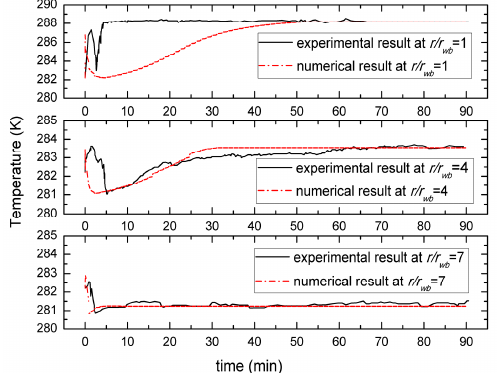
Figure 3. Temperature evolutions of Δ P 6 + Δ T at different sections, experimental data [17] and numerical simulations are shown as solid lines and dashed lines, respectively.